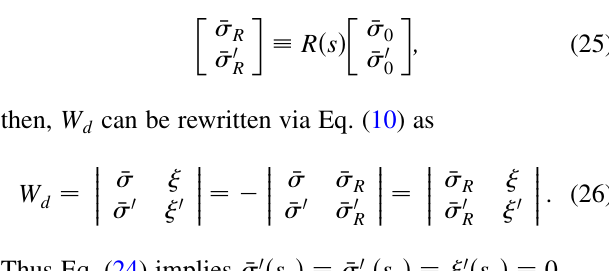
FIG. 1. (Color) (cid:3)(cid:4) , (cid:2) [ 1 = m 2 ], and (cid:2) green, red, and blue,